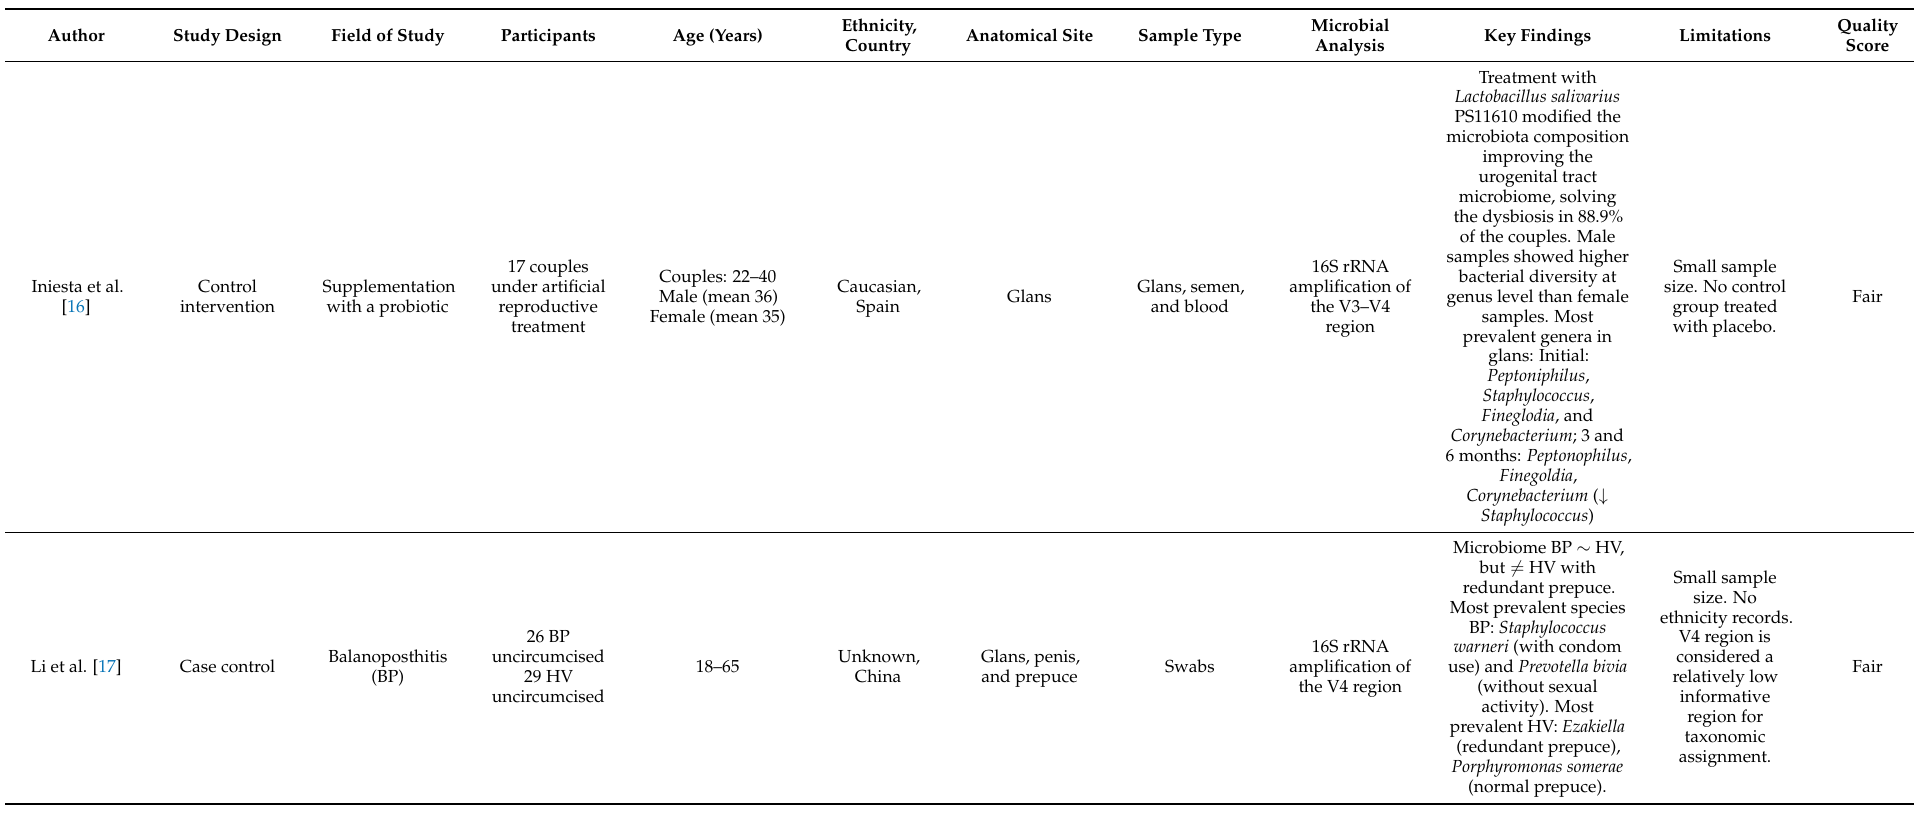
Table 1. Overview of the final selected articles and the characteristics and reported findings. HV = healthy volunteers; CS = coronal sulcus; BP =